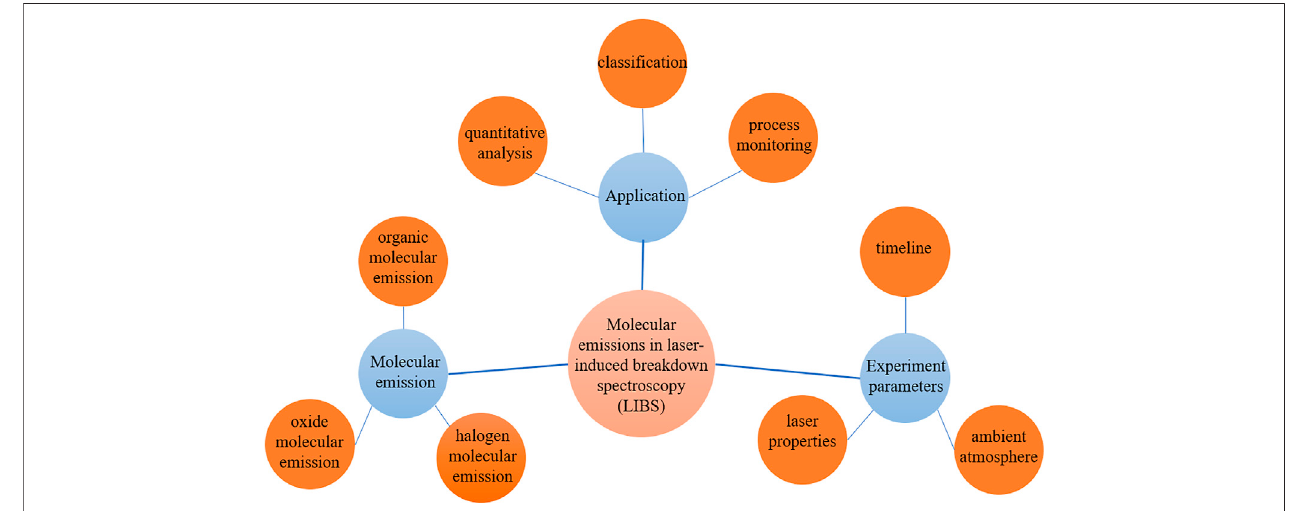
FIGURE 1 | Framework of this